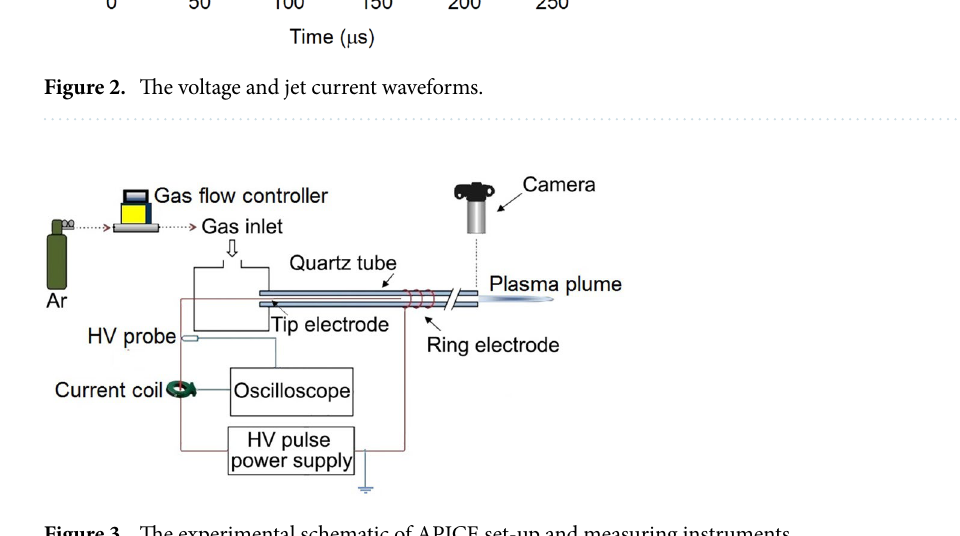
Figure 3. The experimental schematic of APJCE set-up and measuring